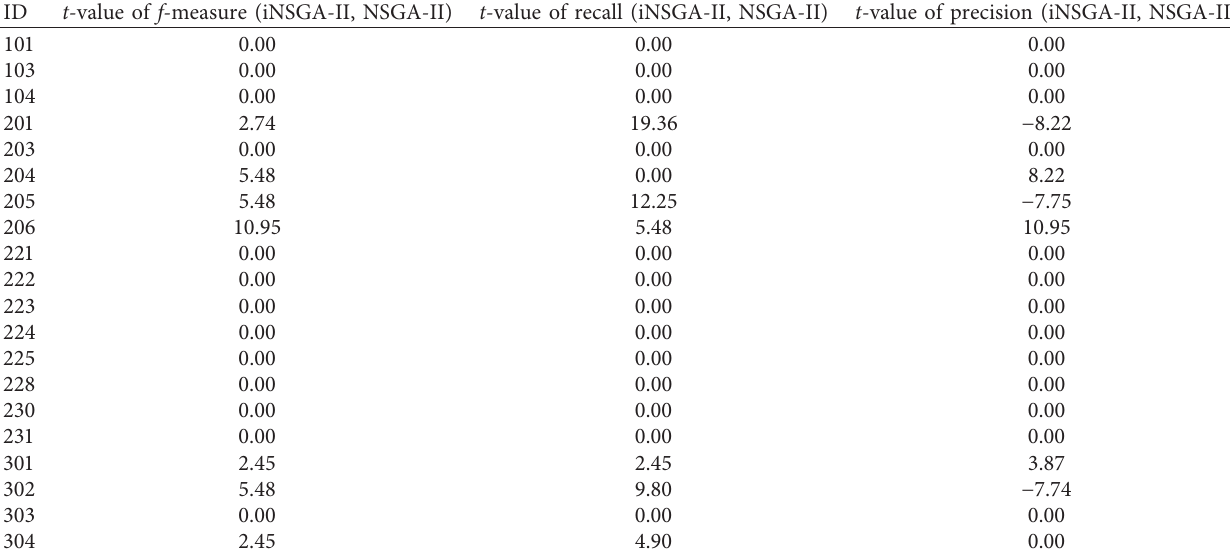
Table 3: The analysis of the t -test